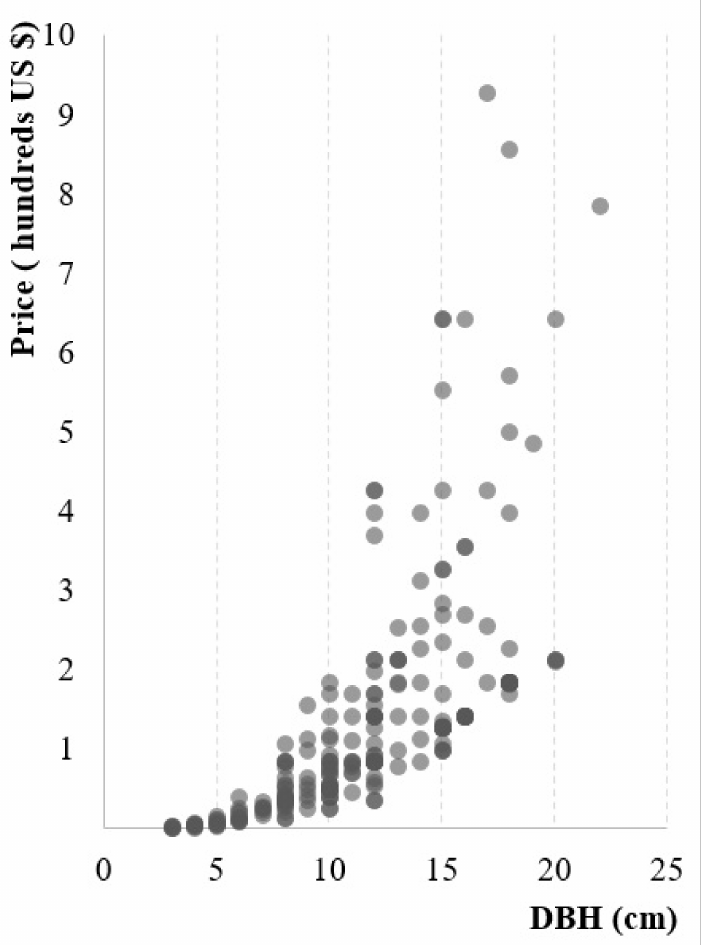
Figure 4. The market price of American sweetgum in different DBH at 2019–2020. DBH: diameter at breast height. Table 2. Estimate of economic loss ( L ) under impacts of SI on sweetgum in the nursery of China (currency unit: USD).